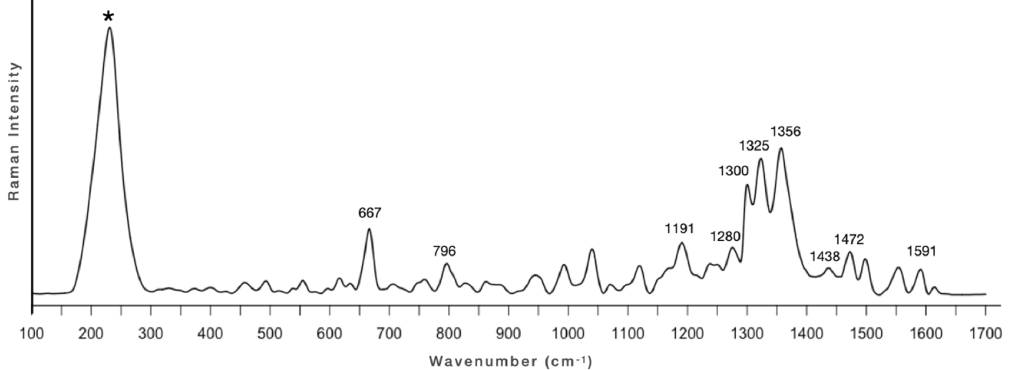
Figure 8. SERS spectrum of sample 1 of the tomba della Nike. Acquisition parameters: 514 nm, 50X